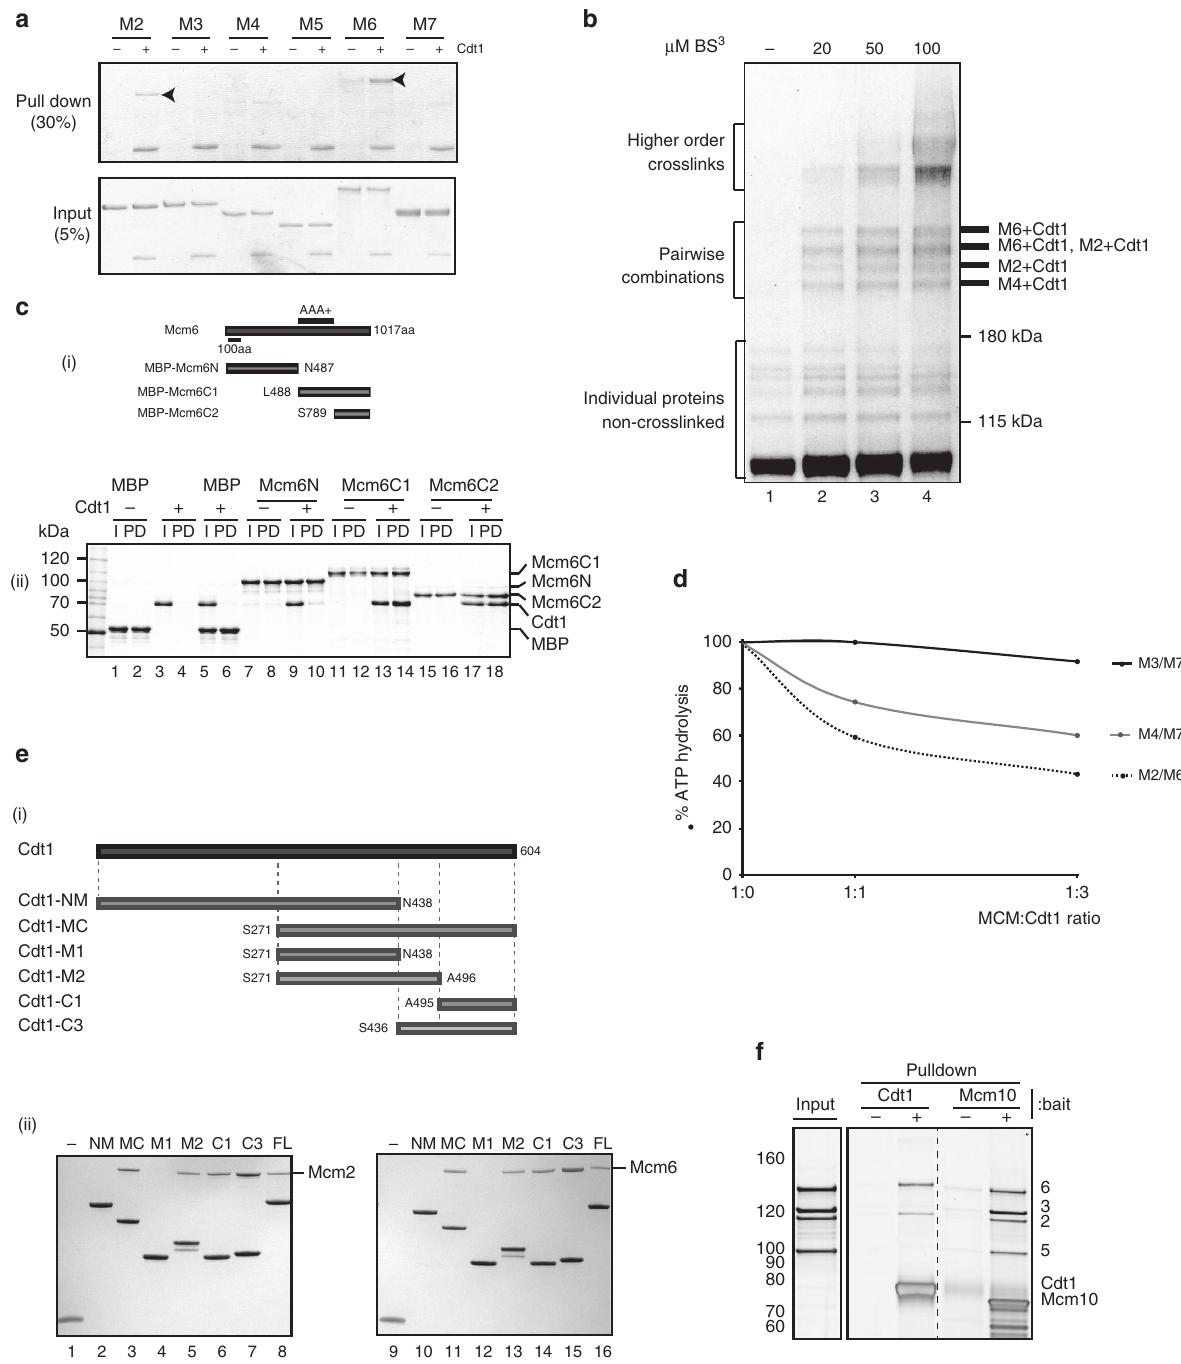
Figure 1 | Biochemical characterization of Cdt1–MCM. ( a ) Interaction of Cdt1 with individual MCM subunits after immunoprecipitation with anti-Cdt1 antibody (arrowheads highlight which individual Mcm interacts directly with Cdt1). ( b ) Crosslinking studies of MCM–Cdt1 FLAG complex. Denaturing immunoprecipitation of Cdt1-FLAG after crosslinking of this complex at indicated concentrations of crosslinker (BS3). Pairwise combinations were identified using immunoblotting and mass spectrophotometry, and summarized on the right. ( c ) Mapping Cdt1 interaction on Mcm6. (i) A series of Mcm6 fragments were fused to MBP tag. (ii) Amilose–agarose pull down of these fragments with the presence of Cdt1. Minus Cdt1 and MBP alone were used as a positive and negative control, respectively. Twenty per cent of the input and 50% of the pull downs were loaded on the gel. ( d ) Effect of Cdt1 on ATPase activity of MCM subunit pairs (M2/M6 ¼ Mcm2–6; M4/M7 ¼ Mcm4–7; M3/M7 ¼ Mcm3–7). ( e ) Mapping domains of Cdt1 interacting with Mcm2 and Mcm6. (i) Cdt1 fragments fused to His-SUMO tag. (ii) His-tag pull downs with the presence of either Mcm2 (left) or 6 (right). His-SUMO protein was used as a negative control ( (cid:2) ). ( f ) Pulldown of Mcm6–2–5–3 tetramer with immobilized Cdt1 or